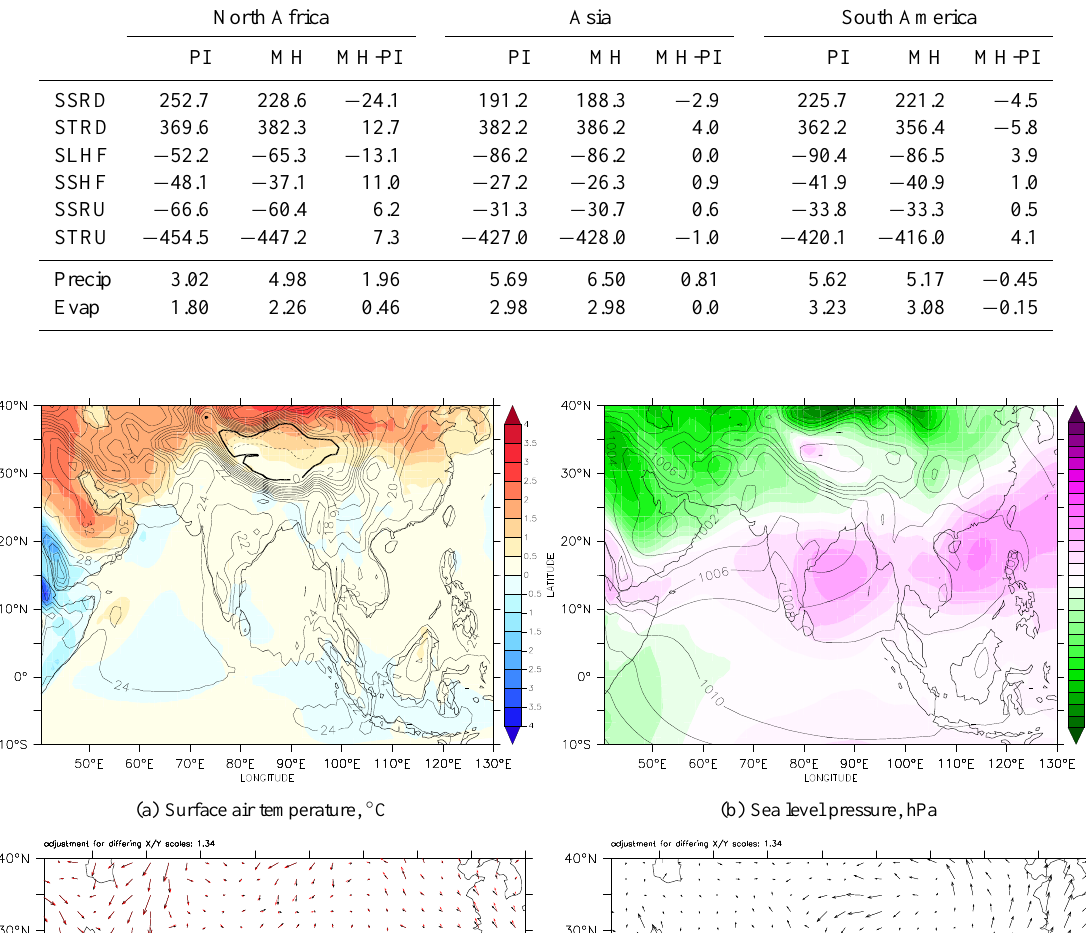
Table 1. PI, MH and difference values of the surface energy budget terms (in Wm − 2 ), precipitation and evaporation (in mmday − 1 ), over land points only, for North Africa (20 ◦ W:40 ◦ E, 5 ◦ N:25 ◦ N, JAS), Asia (60 ◦ E:120 ◦ E, 10 ◦ N:30 ◦ N, JAS) and South America (40 ◦ W:80 ◦ W,